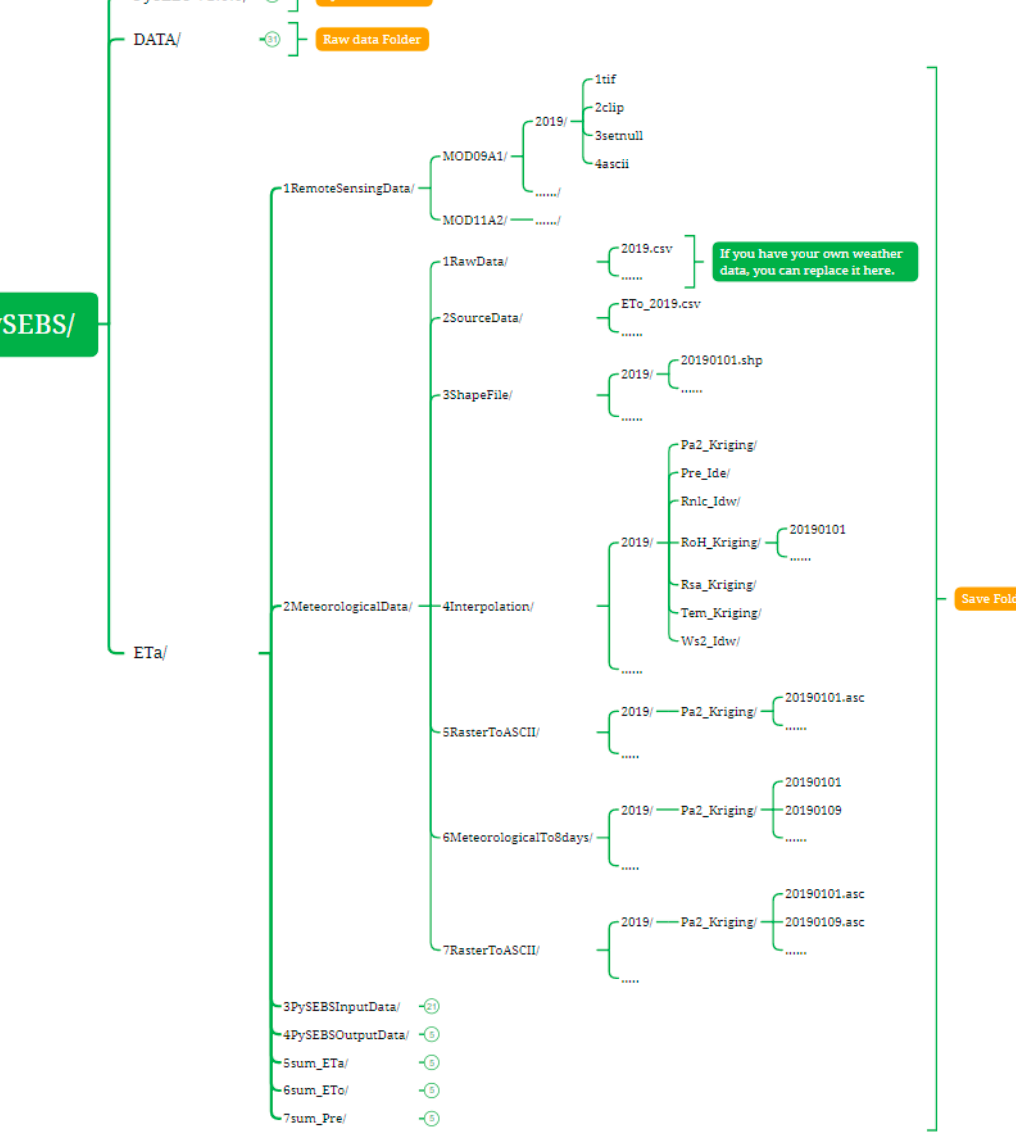
Figure 4. Schematic diagram of the structure of folder 1RemoteSensingData/ and folder 2Meteoro- Figure 4. logicalData/.